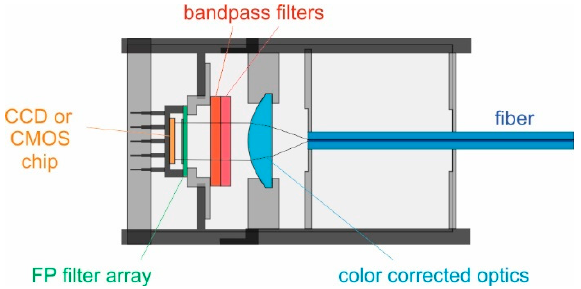
Figure 7. Schematic cross section of an FP filter array mounted parallel and in close vicinity of the Si detector array (CCD or CMOS). The divergent light of the fiber is made almost parallel by the lens system. In this option, the FP filter array is defined on a glass substrate which is aligned here in a bottom-up way on the CCD or CMOS photodiode array. As a comparison, in the first option shown previously in Figure 4 the FP filter array is defined directly on the detector array.